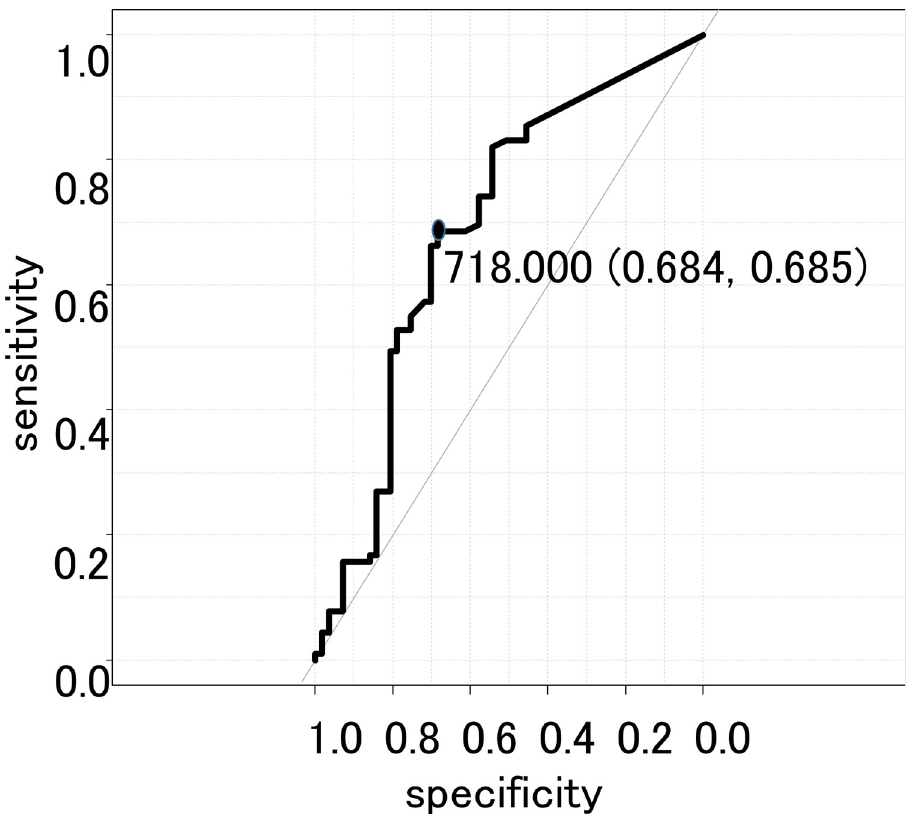
Fig 4. Sensitivity and specificity validation analysis on receiver operating characteristics (ROC) curve. ROC analysis defined a c-D11-index of 718 as the best cutoff value to discriminate between patients who develop FN after day 11 and those who do not. The sensitivity and specificity of ROC curve analysis were 68.5% and 68.4%, respectively.